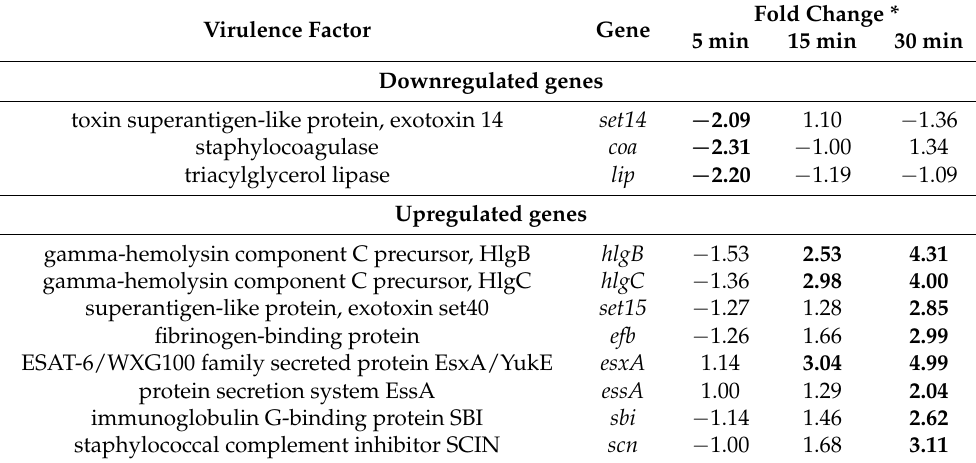
Table 2. Expression of SA515 genes related to virulence after phage